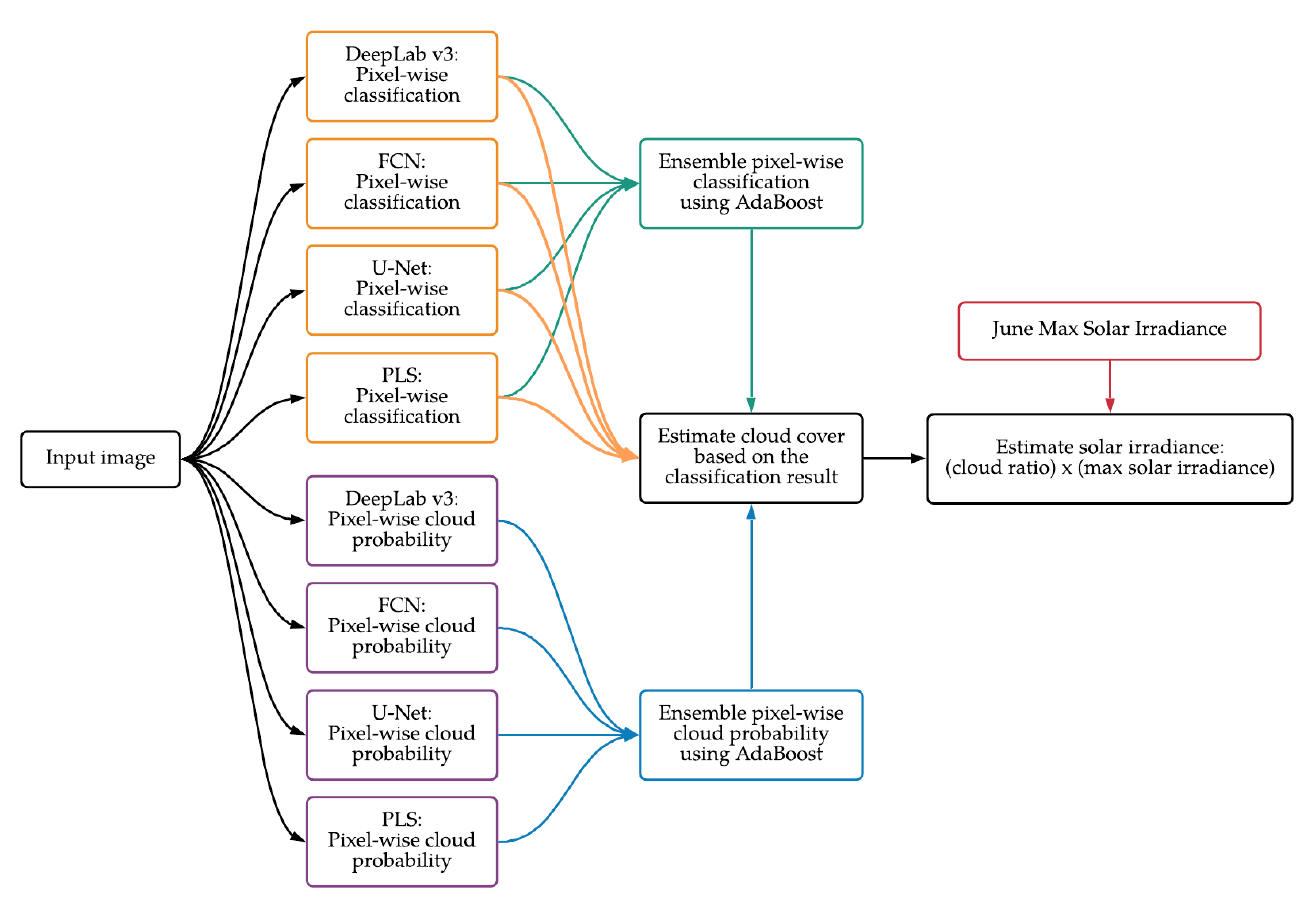
Figure 1. Data-processing flow for cloud cover measure and solar irradiance